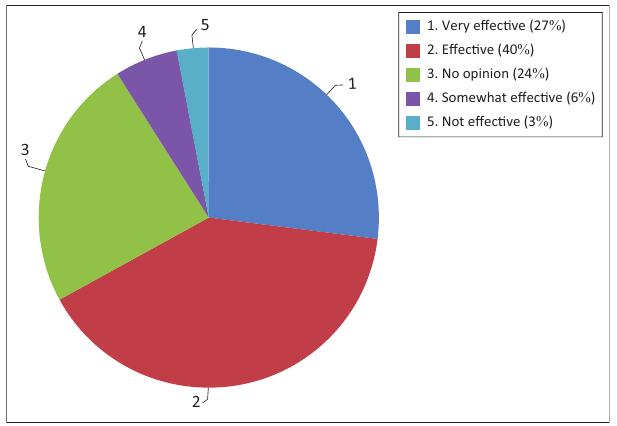
FIGURE 1: Participants’ opinions of communities of practice as a knowledge transfer tool ( n =